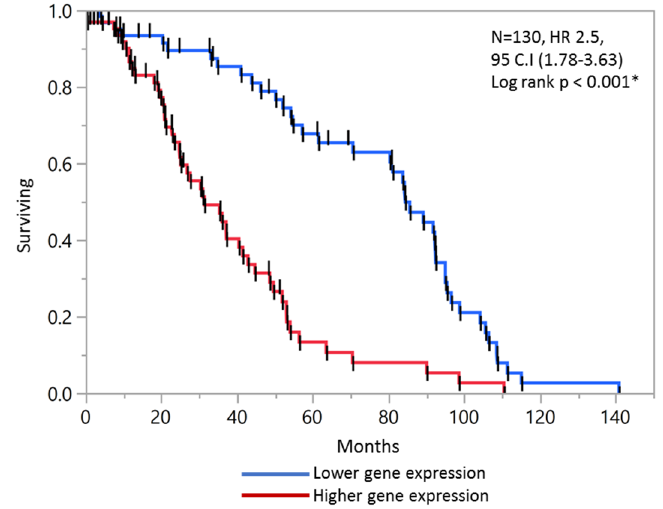
Figure 5. The prognostic score di ff erentiated CRC patients in stage II + III in combined internal and external datasets.